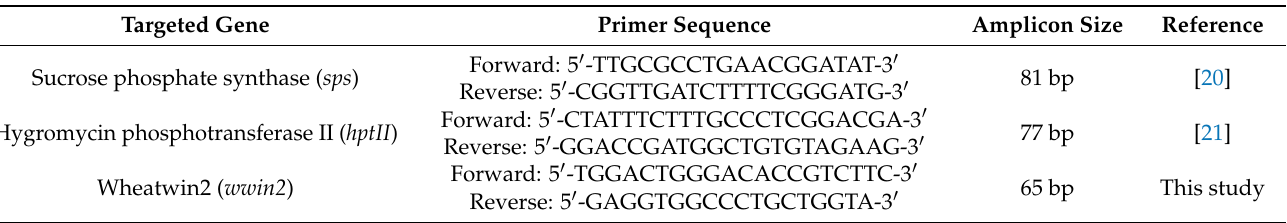
Table 1. Primer sequences used in the PCR analysis.